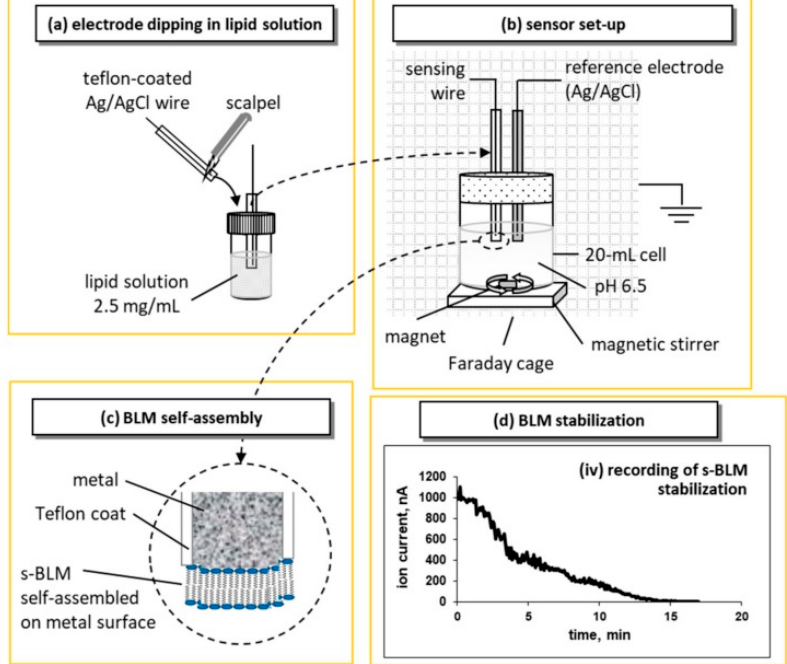
Figure 1. Representation of the device setup, and the lipid self-assembly process for the preparation of metal-supported stabilized bilayer lipid membranes (sBLMs; not drawn to scale) based on the original idea of [2]: ( a ) the tip of the sensing electrode is cut with a scalpel and immediately dipped in lipid solution before transferred in the electrolyte solution. ( b ) The electrochemical setup uses a two-electrode configuration (i.e., the sensing electrode and a Ag/AgCl reference electrode) in a magnetically stirred 20 mL cell. The set-up is placed in a grounded Faraday cage; 25 mV external DC potential is applied between the electrodes; the ionic current through the BLM is measured with a digital